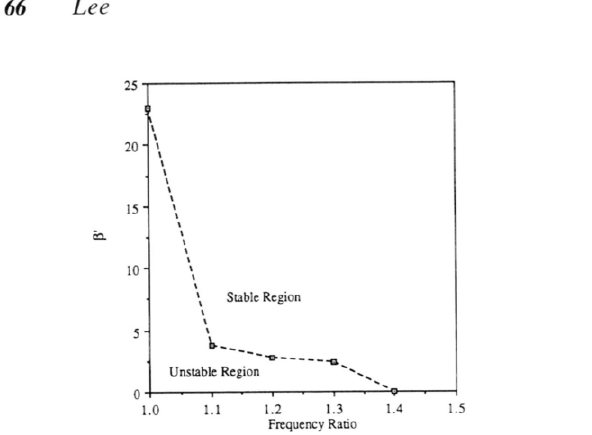
FIGURE 11 Perturbed ball motion versus nondi mensional time (w = 1.5). Initial conditions: xo(O) = .90(0) = 0.01, i o(O) = Yo(O) = 0, ¢ sl = 3.13, ¢ s2 = 3.15, ¢I(O) = ¢ 2(0) = 0.5, ¢I(O) = ¢2(0) = 0, 1'/1 = 0.005, R = 0.001 , and {3' = .01.